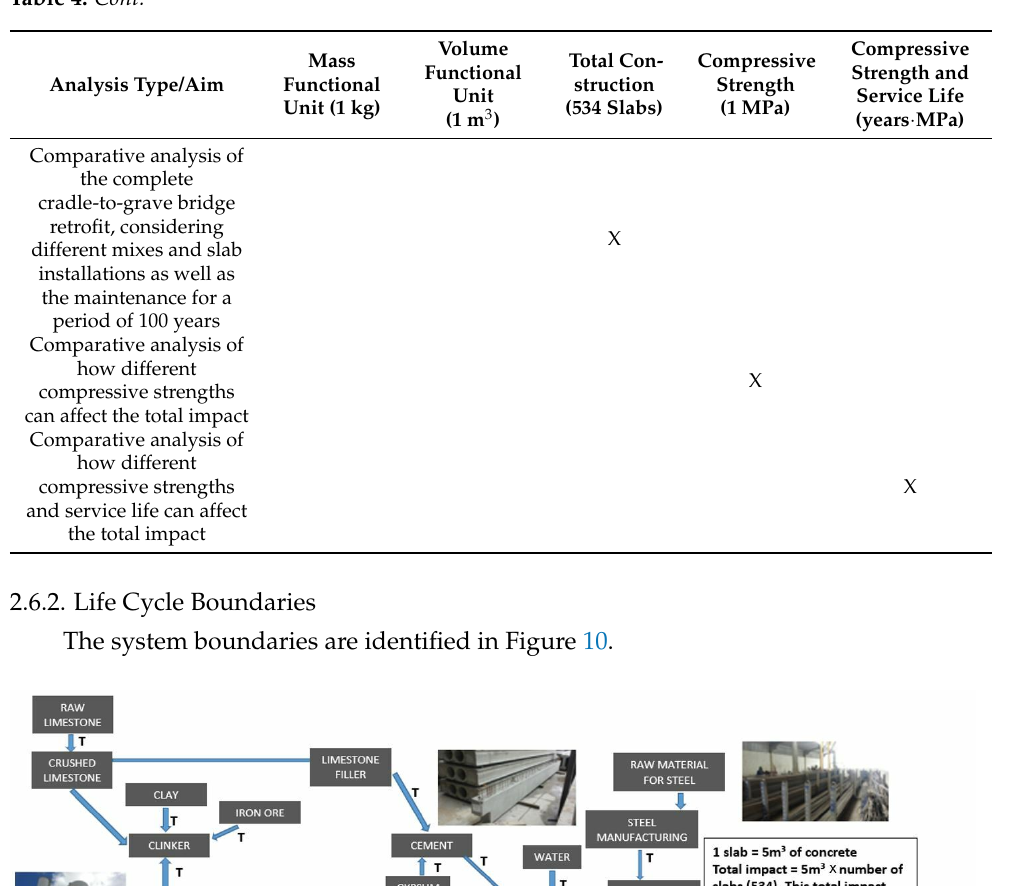
Table 4. Functional units used in the current study to evaluate each different aspect of the environ- mental impact categories analyzed.